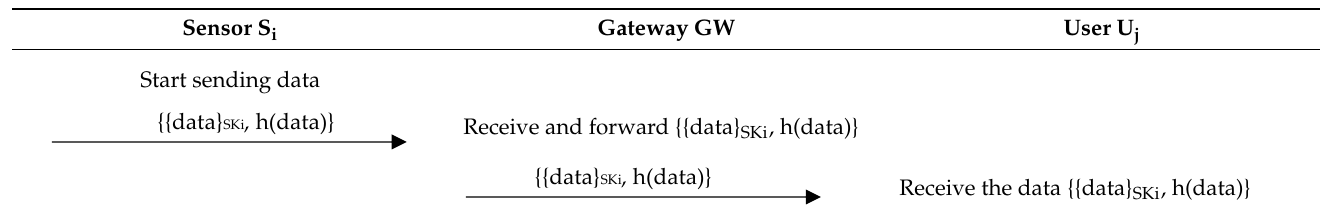
Table 7. Data exchange phase.